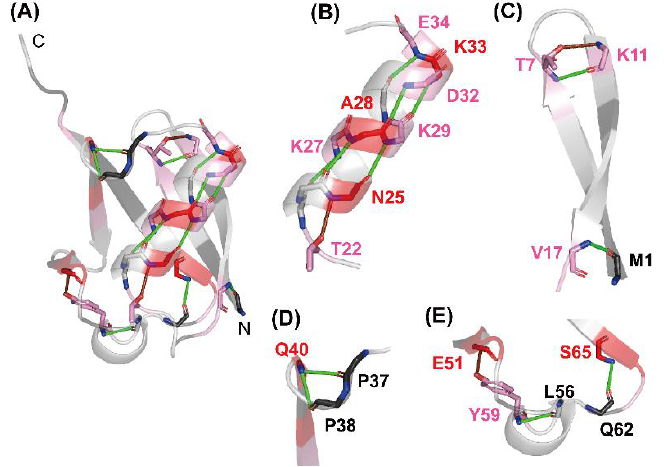
Figure 5. The H-bonding network observed in native ubiquitin (PDB code: 1UBQ). ( A ) A whole view, and ( B – E ) closer views of ( B ) the middle α -helix, ( C ) the N-terminal β -hairpin, ( D ) the one-turn 3 10 helix (Pro38–Gln40), and ( E ) the Type II β -turn (Gln62–Ser65) and the one-turn 3 10 helix (Ser57–Tyr59) are shown. The H-bonds of the NH protons of Thr7, Val17, Lys27, Ala28, Lys29, Asp32, Lys33, Glu34, Gln40, Tyr59, and Ser65 with the CO groups of their counterparts are shown as green lines. The local H-bonds formed by the NH protons of Lys11, Asn25, and Glu51 with the side-chain atoms of Thr7, Thr22, and Tyr59, respectively, are shown as brown lines. The red gradient indicates the same P value scale as shown in Figure 2. Adapted with permission from Ref. [136]. Copyright